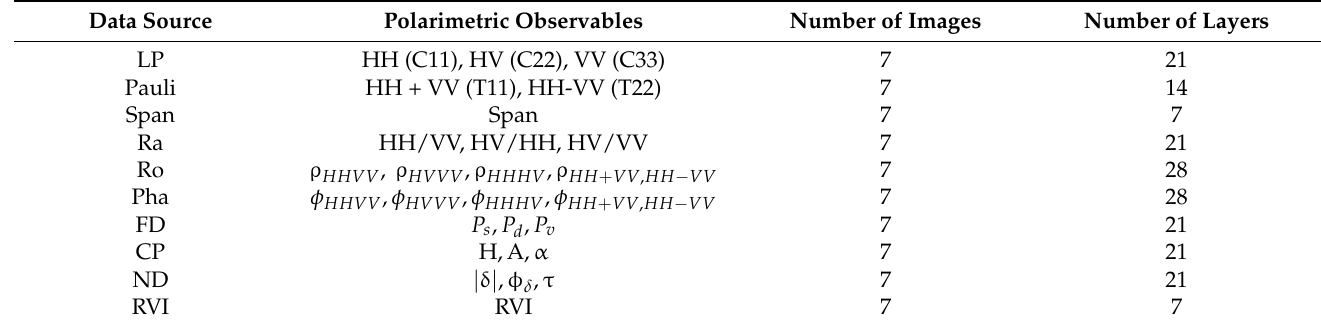
Table 4. The detailed descriptions of the combinations of input polarimetric observables. Note that abbreviations are explained in Table